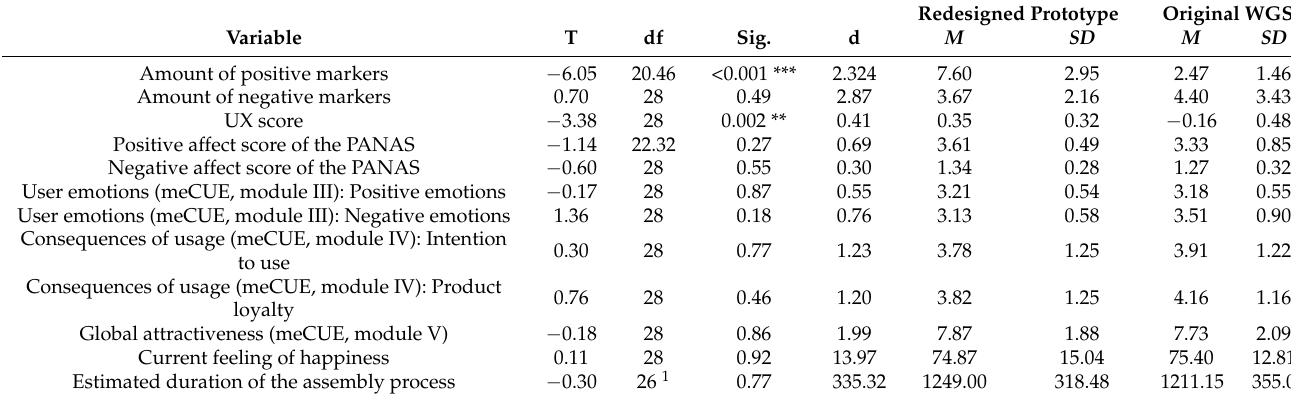
Table 10. Results of t